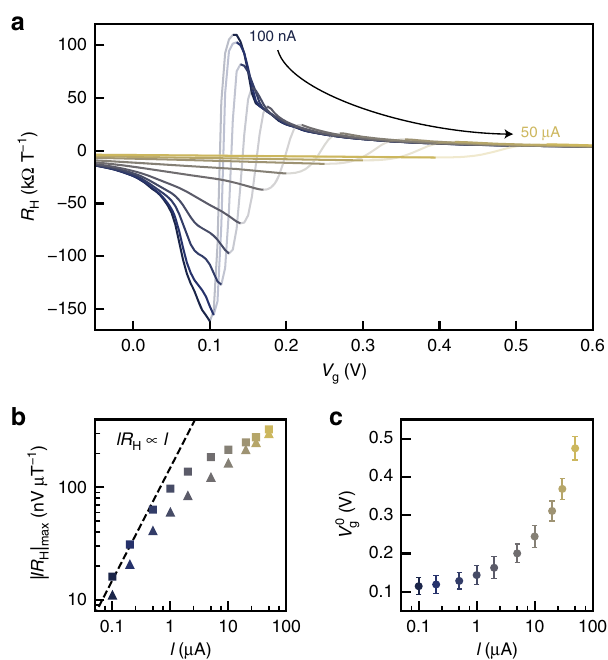
Fig. 3 Hall coef fi cient measurements. a Hall coef fi cient R H for device G1 under varying dc current bias at 4.2 K. b Bias current dependence of the peak value of IR H . c Bias current dependence of the charge neutrality point voltage V g 0 . Error bars represent the uncertainty in determining the point at which R H crosses